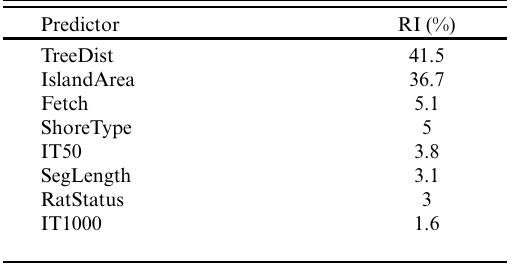
Table 6 . Relative Influence (RI) of predictors in final model. Values are the mean over 10 model